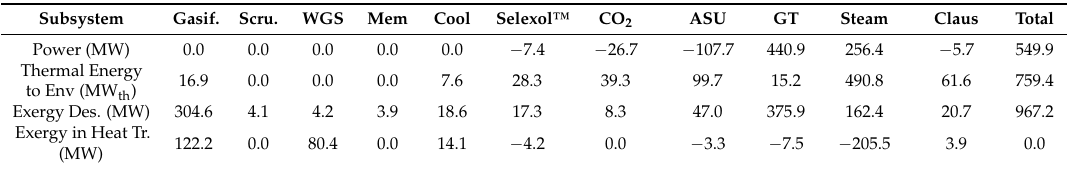
Table 9. Carbon Dioxide Membrane Model results, assigning all exergy destruction associated with heat transfer between subsystems to the Steam